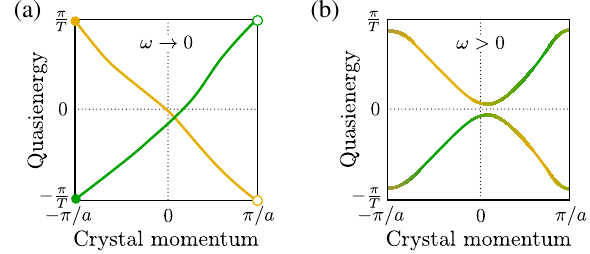
FIG. 8. Floquet spectrum for Thouless ’ s quantized adiabatic charge pump. (a) Quantized adiabatic pumping in a 1D system is manifested in chiral Floquet bands that wind around the quasie- nergy Brillouin zone (right and left movers are shown in green and orange, respectively). (b) Outside of the adiabatic limit, ω > 0 , counterpropagating states hybridize, and all Floquet bands obtain trivial winding numbers; quantized pumping is